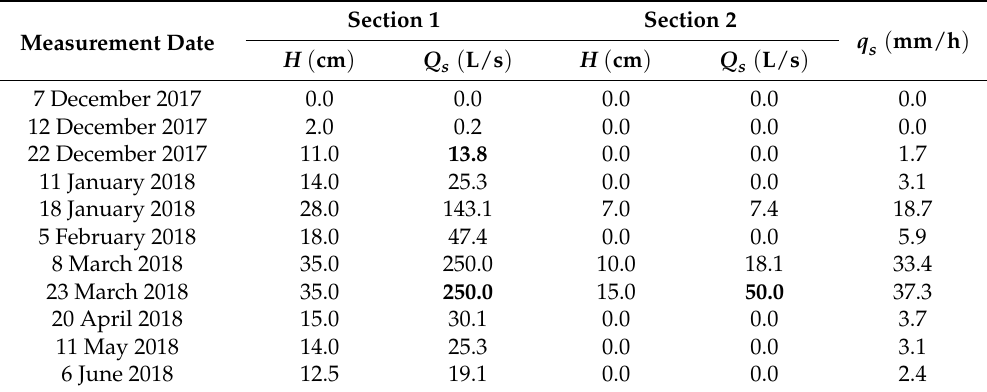
Table 3. Measured water levels, estimated flow discharges in the two monitored stream sections, and estimated specific spring discharge from the whole drained area. Bold values represent discharge estimated by measuring the cross-sectional area and estimating the mean flow velocity. The other discharge values are obtained by means of Equation